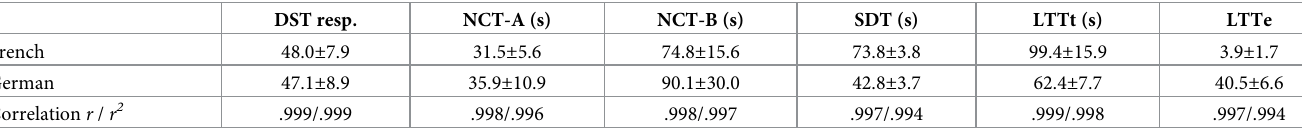
Table 4. Relationship between French and seminal German